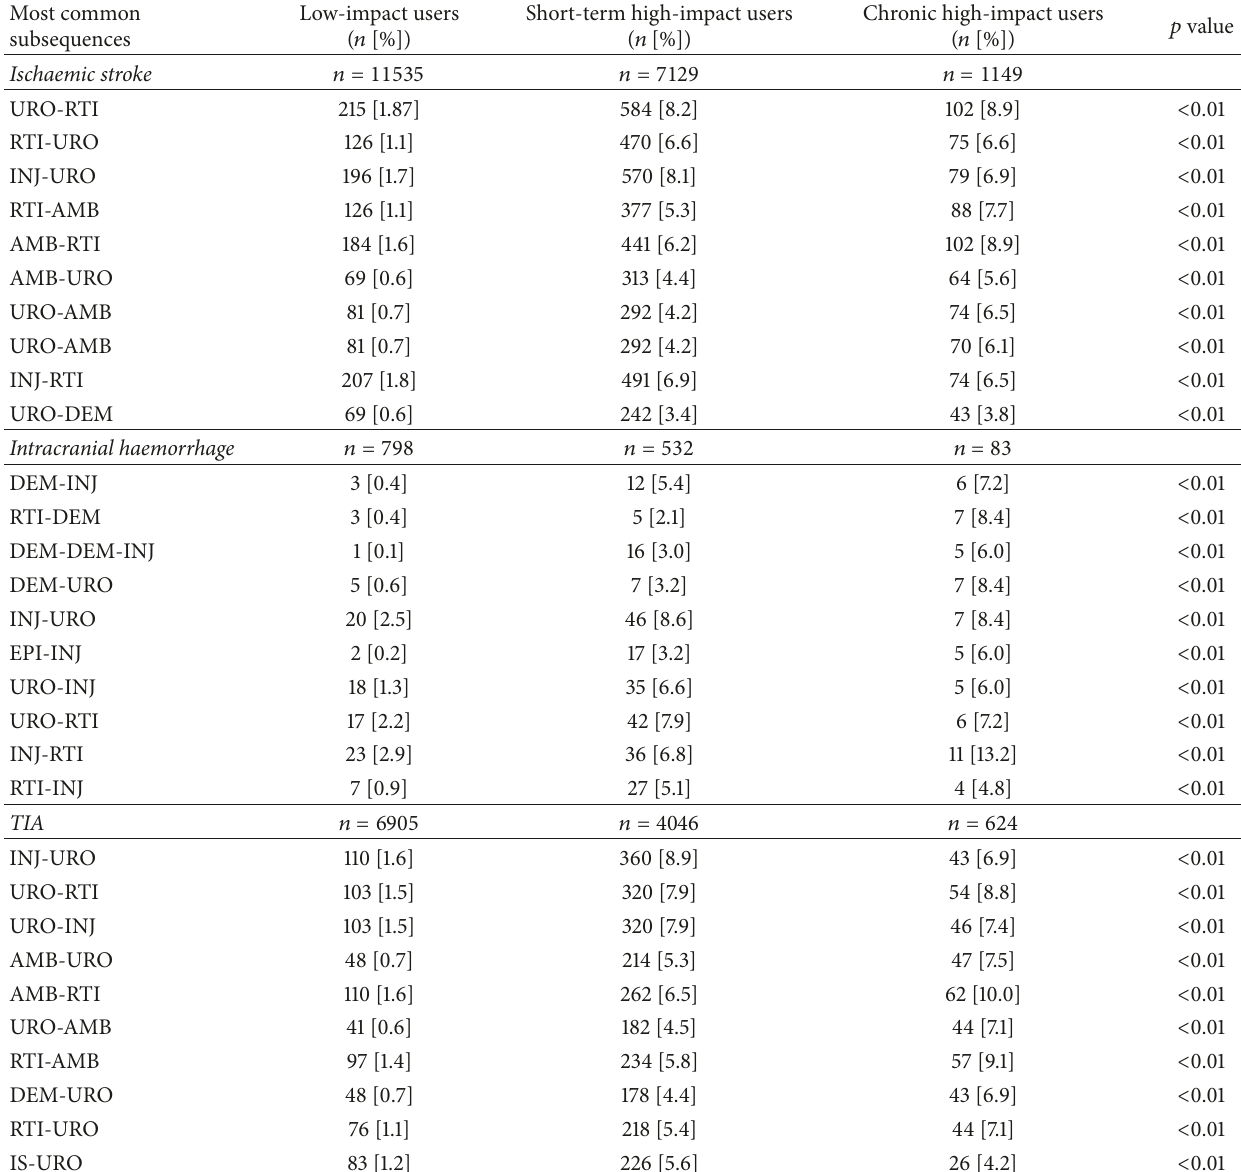
Table 3: Most common subsequences in the subgroups of cerebrovascular conditions (urine infection and urological conditions [URO], respiratory tract infection [RTI], external injuries [INJ], ambulatory conditions [AMB], dementia [DEM], cerebrovascular conditions [IS], and epilepsy/seizure